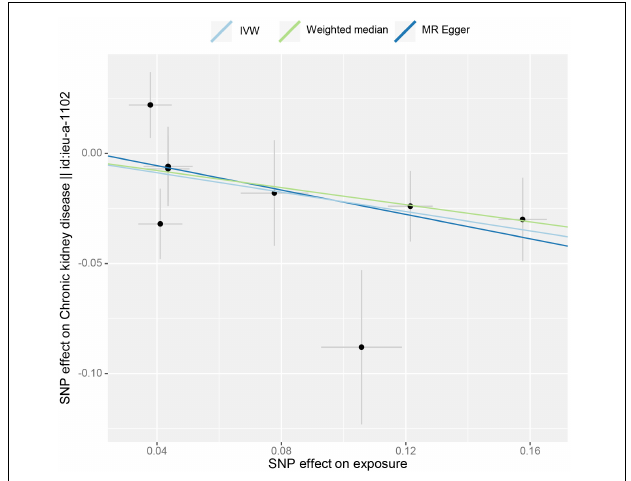
FIGURE 2 | Scatter plot of the effect size for each SNP on tea consumption and CKD G3–G5.